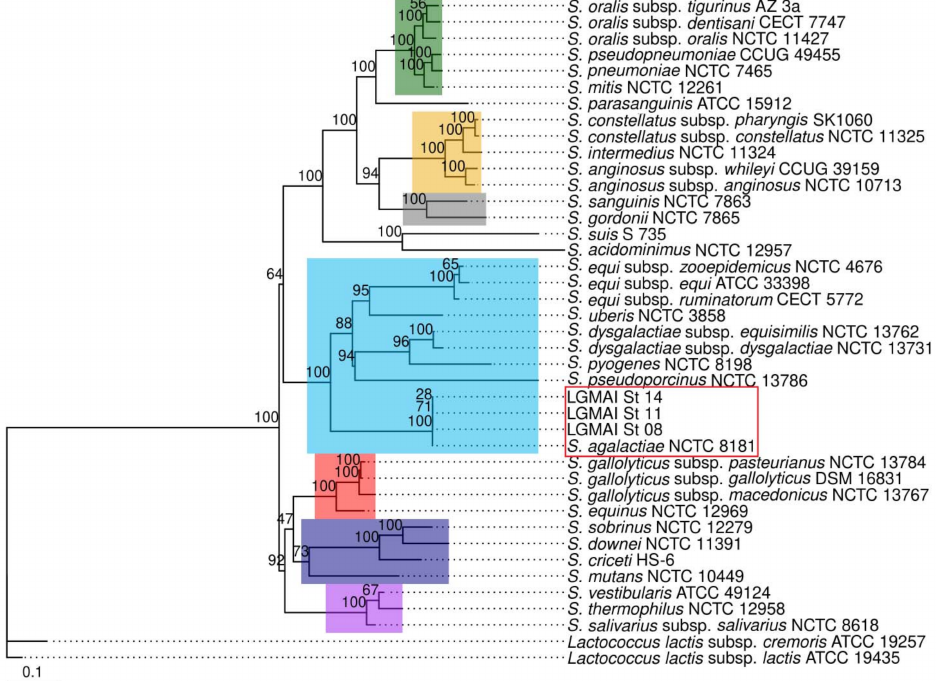
Figure 1. MLSA resultant phylogenetic tree, using the genes aroE , gki , pheS , recA , and the 16S rDNA, and inferred with the maximum likelihood method and the general time-reversible model. Lactococcus lactis subspp. cremoris and lactis were used as outgroups to root the tree. A rectangle with red borders highlights the bovine strains grouped with the reference Streptococcus agalactiae NCTC 8181. In colored rectangles are the streptococcal putative monophyletic groups found in the analysis (green = Mitis, yellow = Anginosus, gray = Sanguinis, light blue = Pyogenes, red = Bovis, dark blue = Mutans, and purple = Salivarius).